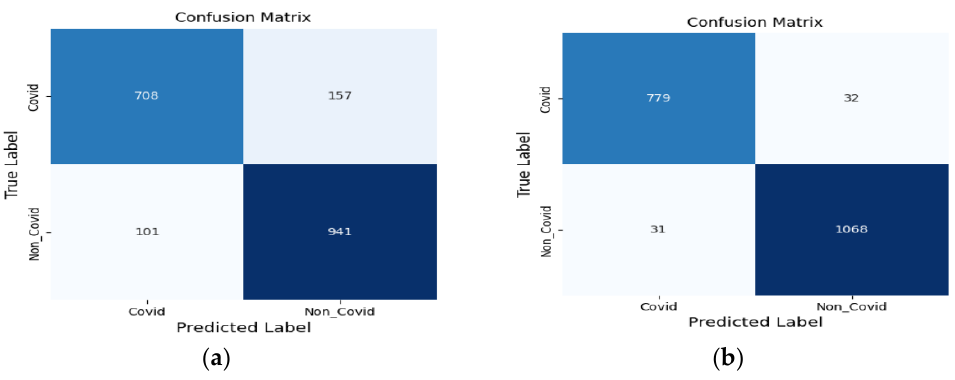
Figure 7. Confusion matrix for the COVID-19 CXR classification. ( a ) (Baseline) non-pretrained ResNet - 50. ( b ) (Proposed) pretrained ResNet - 50.